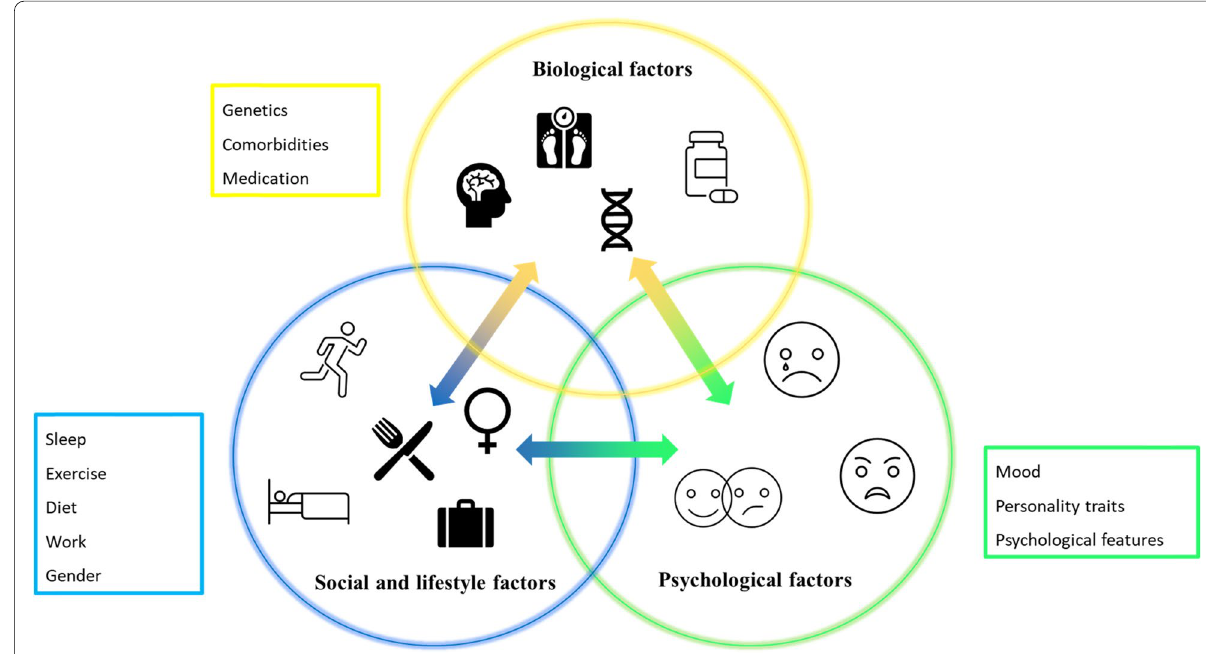
Fig. 2 Biological, social, and psychological factors influencing